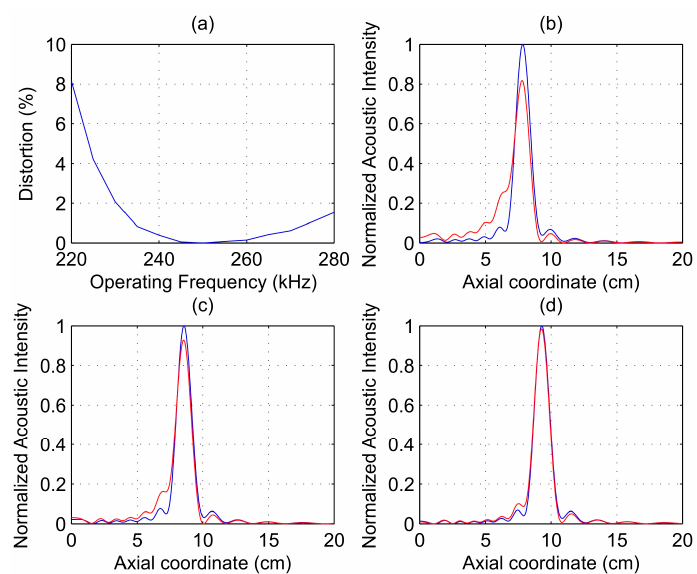
Figure 5. ( a ) Focal distortion against operating frequency; ( b – d ) Simulated acoustic intensity against